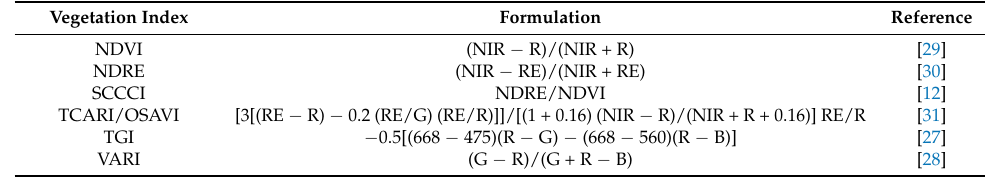
Table 2. Vegetation indices computed from the spectral reflectance collected with the unmanned aerial system (UAS). The band centres used in this study for computing the spectral indices were 475, 560, 668, 717 and 840 nm for the blue, (B), green (G), red (R), red-edge (RE) and near infrared (NIR) bands,